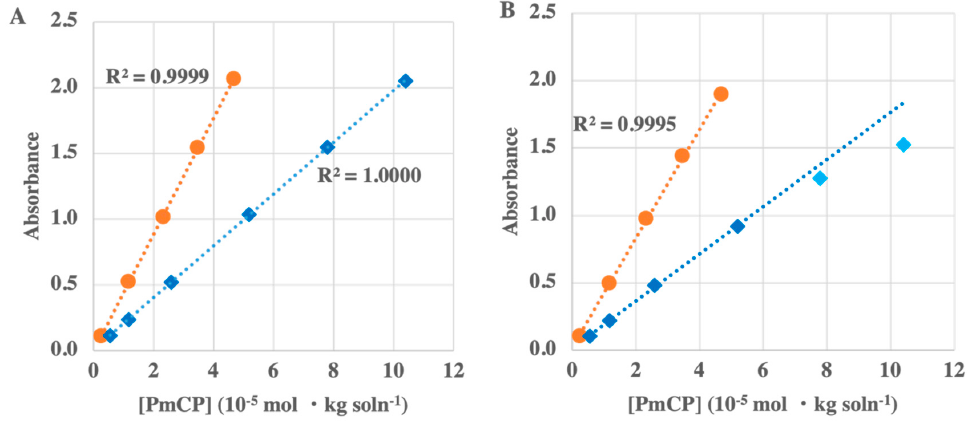
Figure 2. (Absorbance linearity). Absorbance was measured in triplicate by the pHyter over a range of mCP concentrations at pH 5 and 11. The orange circles represent 578 nm absorbance from the pH 11 solution; the blue diamonds represent 434 nm absorbance from the pH 5 solution. The light blue diamonds represent points deviating from the linear response at 434 nm. ( A ) A pHyter with 10-nm bandpass filters on each LED; ( B ) a pHyter without bandpass filters. Table 1. (pHyter measurements of Tris CRM pH). Measurement of Tris pH by five individual pHyter instruments at three different temperatures. The average and standard deviation are across the five instruments. The value in red indicates an apparent outlier. Values in parentheses indicate the average and standard deviation without the